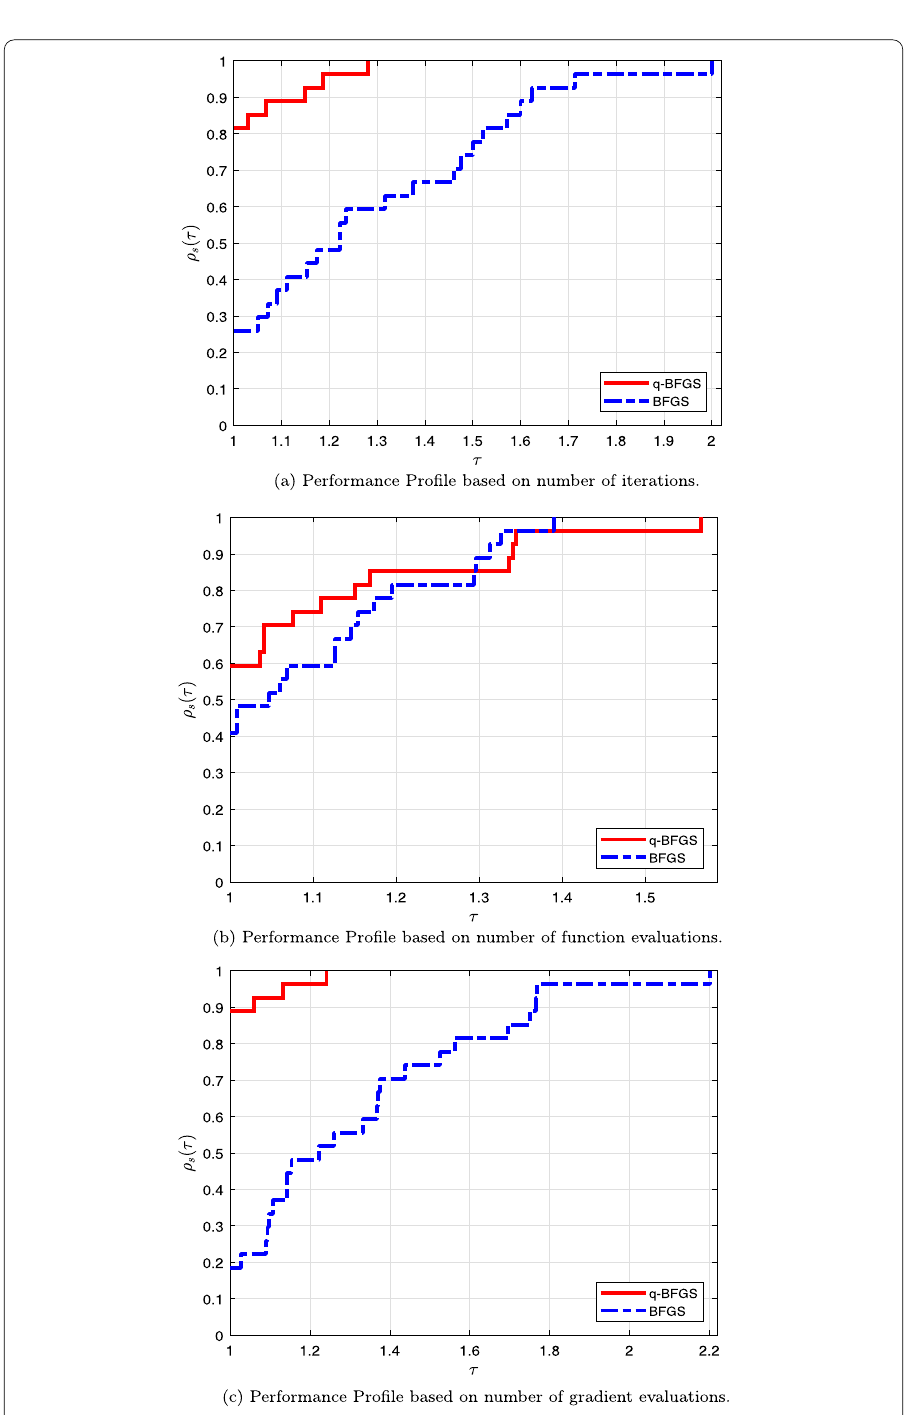
Figure 4 Performance profiles based on the number of iterations, the number of function evaluations and the number of gradient evaluations given in Tables 3 and